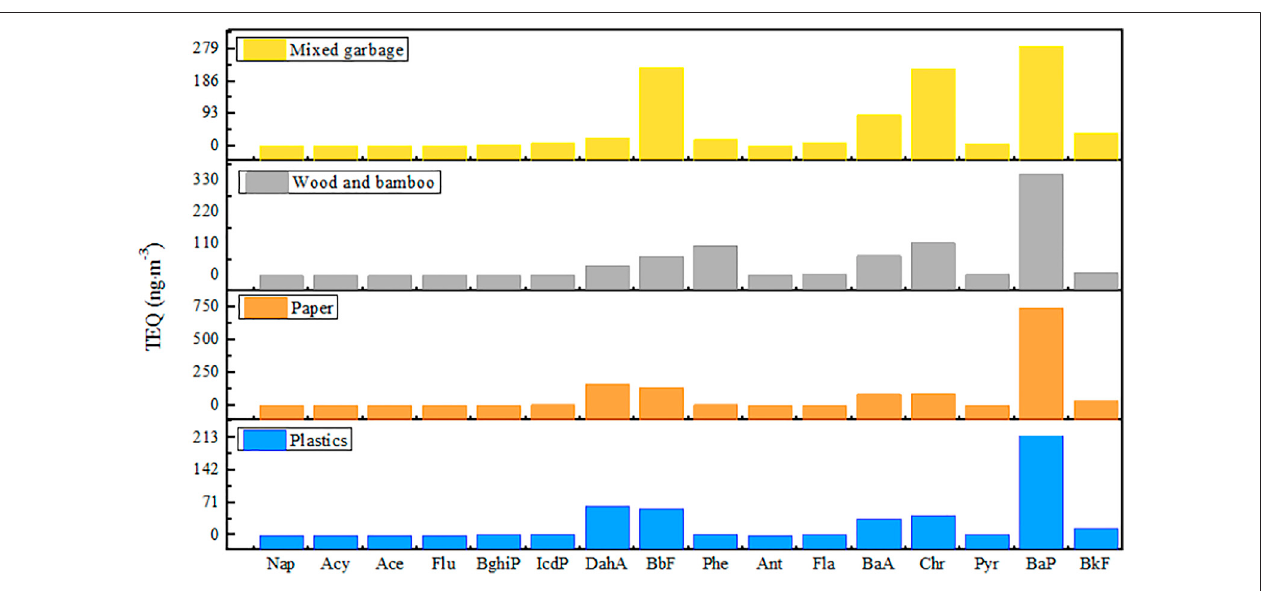
FIGURE 4 | The distribution characteristics of TEQ of